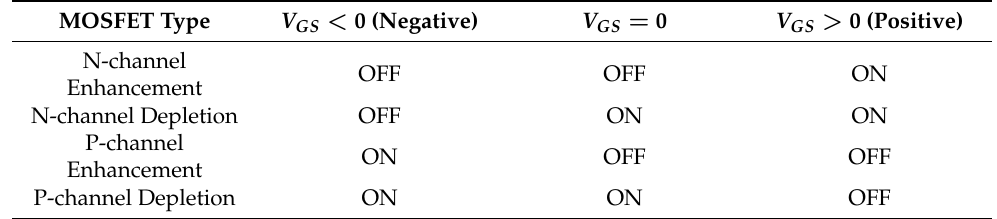
Table 1. The switching characteristics for both N-channel and P-channel type